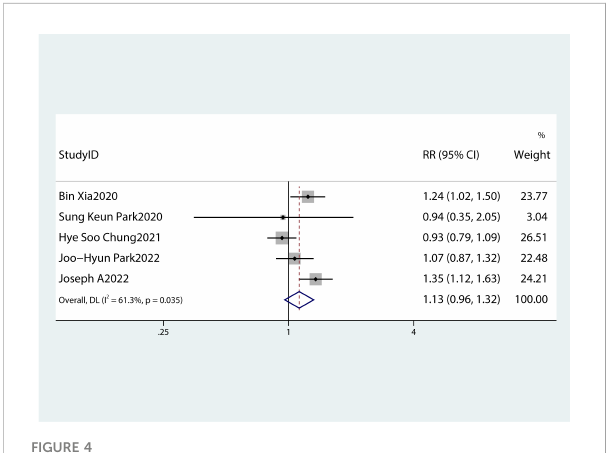
FIGURE 5 A forest plot demonstrating the relationship between hypertriglyceridemia and the risk of pancreatic